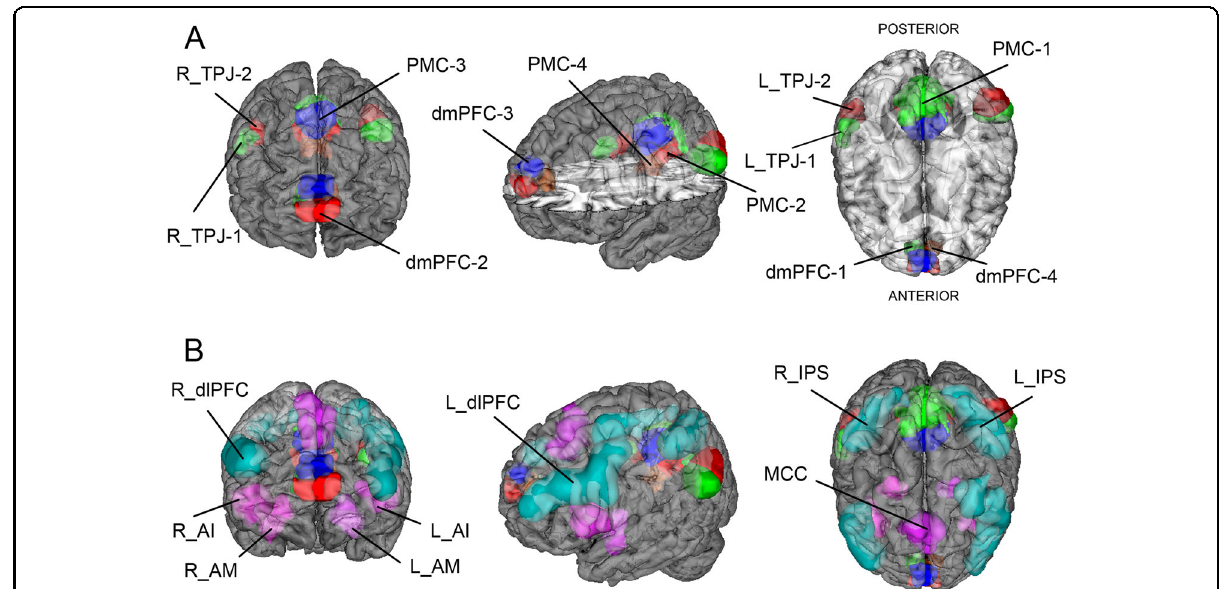
Fig. 1 Target network de fi nitions. The regions of interest (ROIs) used for all present analyses are rendered on the MNI standard brain with frontal, diagonal, and top views. a The four main default mode network (DMN) nodes are subdivided into 12 ROIs re fl ecting distinct subregions (dmPFC1 – 4, PMC1 – 4, left and right TPJ1 – 2) 37 – 40 . b The DMN subregions are supplemented by nine ROIs for the dorsal attention network (DAN) and